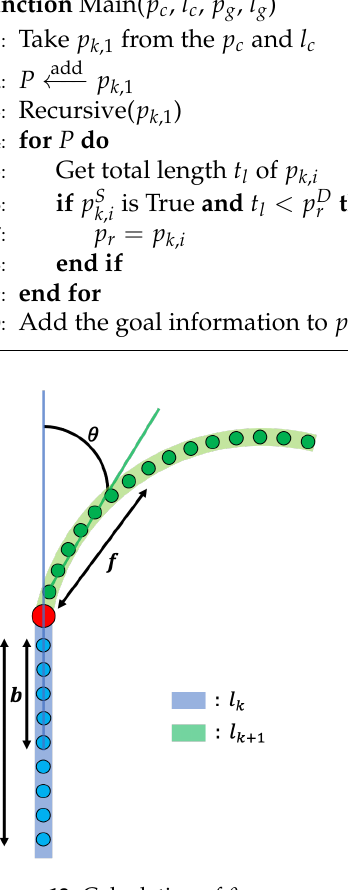
Figure 13. Calculation of θ